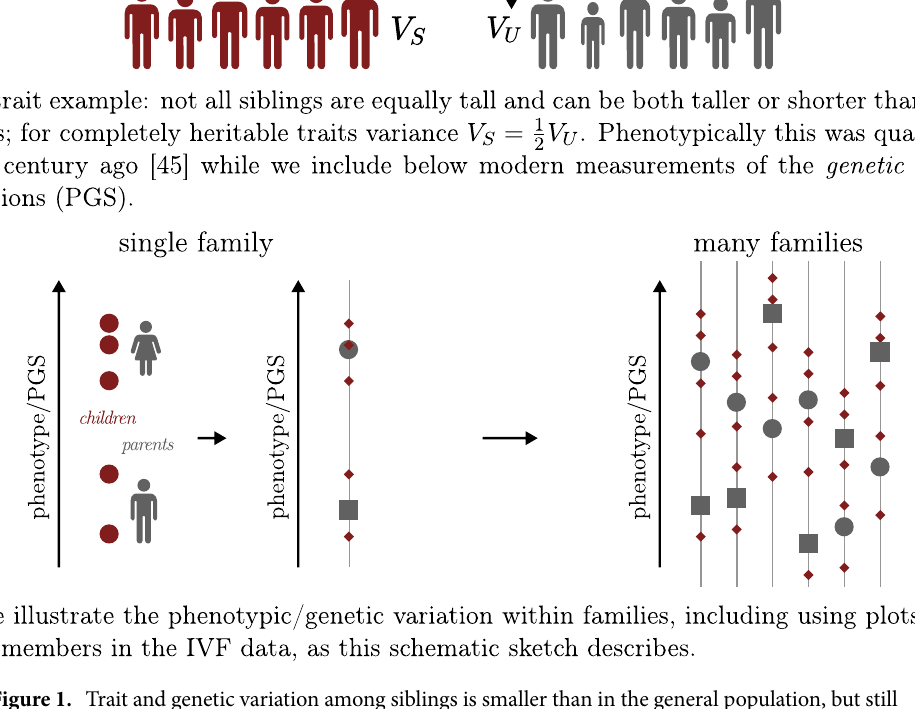
Figure 1. Trait and genetic variation among siblings is smaller than in the general population, but still significant. Population genetics theory implies that the standard deviation in sibling PGS is √ 2 smaller than for the general population. We demonstrate this empirically using UKB and IVF clinic data, and illustrate that variation in important traits and disease risks among siblings is substantial. Note that the exact √ 2 relation only holds at the phenotypic level if the trait is 100%